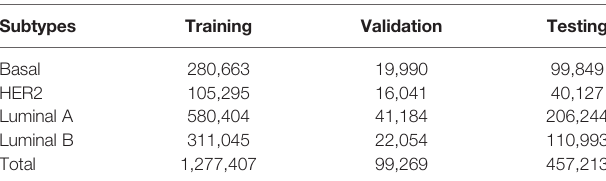
TABLE 1 | Training, validation, and testing sets for each subtype of breast cancer in the TCGA-BRCA dataset.